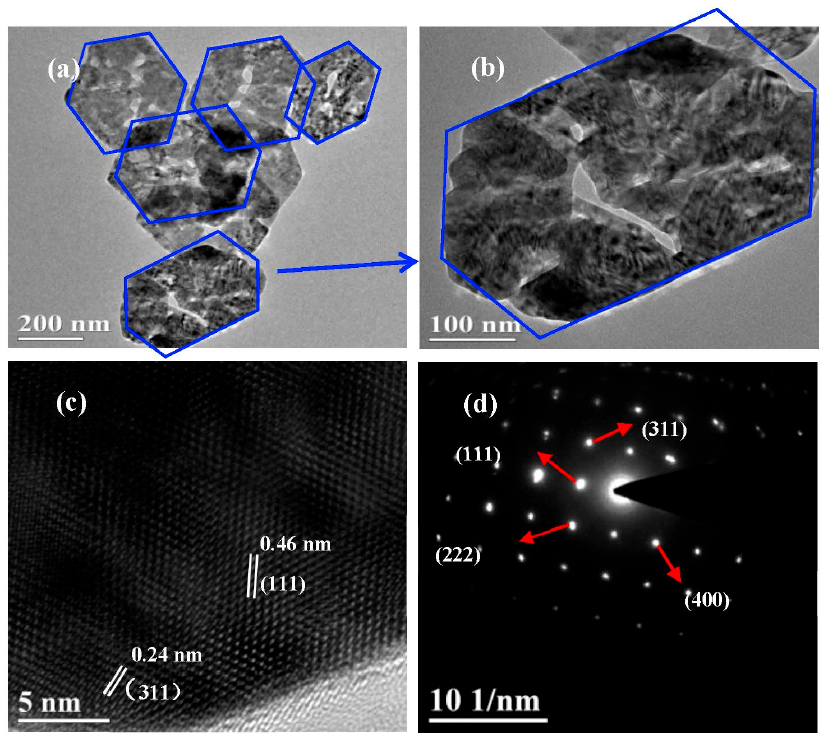
Figure 3. TEM images ( a , b ), HRTEM image ( c ) and SAED pattern (d) of the CuCo 2 O 4 nanoplatelets.